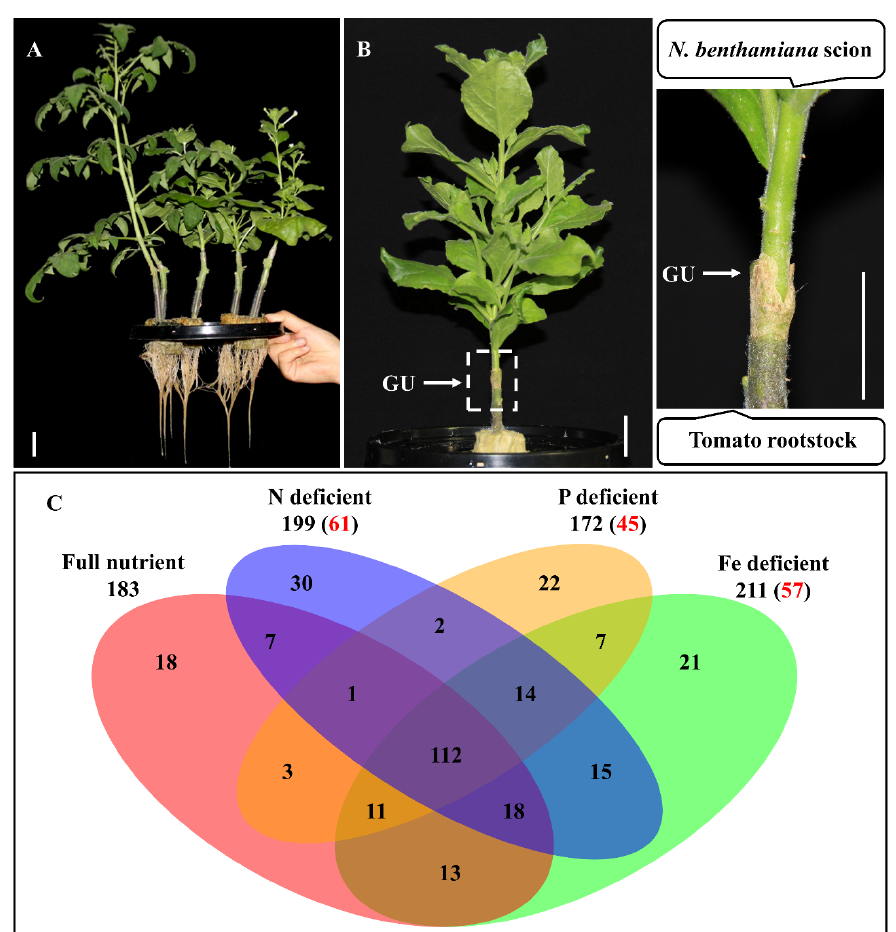
Figure 1. Shoot-to-root mobile mRNAs identified from the N. benthamiana / tomato heterografts grown in a hydroponic condition. ( A ) No visible phenotypic alterations were observed in the roots of the homograft (left two tall plants) and the heterograft (right three short plants) plants. Bars = 2 cm. ( B ) Representative heterograft established between N. benthamiana and tomato. The dashed box indicates the graft union (GU). Bars = 2 cm. ( C ) Venn diagram shows the overlaps and specificities of mobile mRNAs detected in full nutrient and N, P and Fe deficiency conditions. Numbers in the brackets indicated the quantity of mRNAs specifically induced by the individual mineral